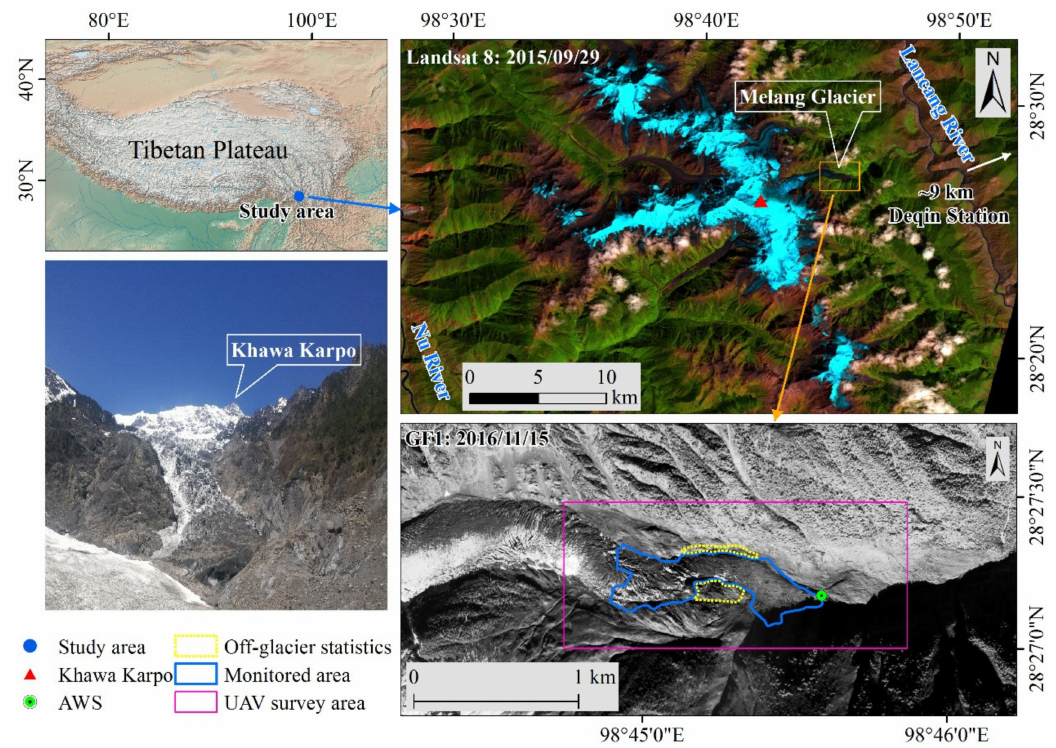
Figure 1. Location of Melang Glacier meteorological station in the Mainri Mountains, the glacier terminus and the extent of the surveyed area and the off-glacier validation regions. The projections of Landsat and GaoFen images are WGS84/UTM ZONE